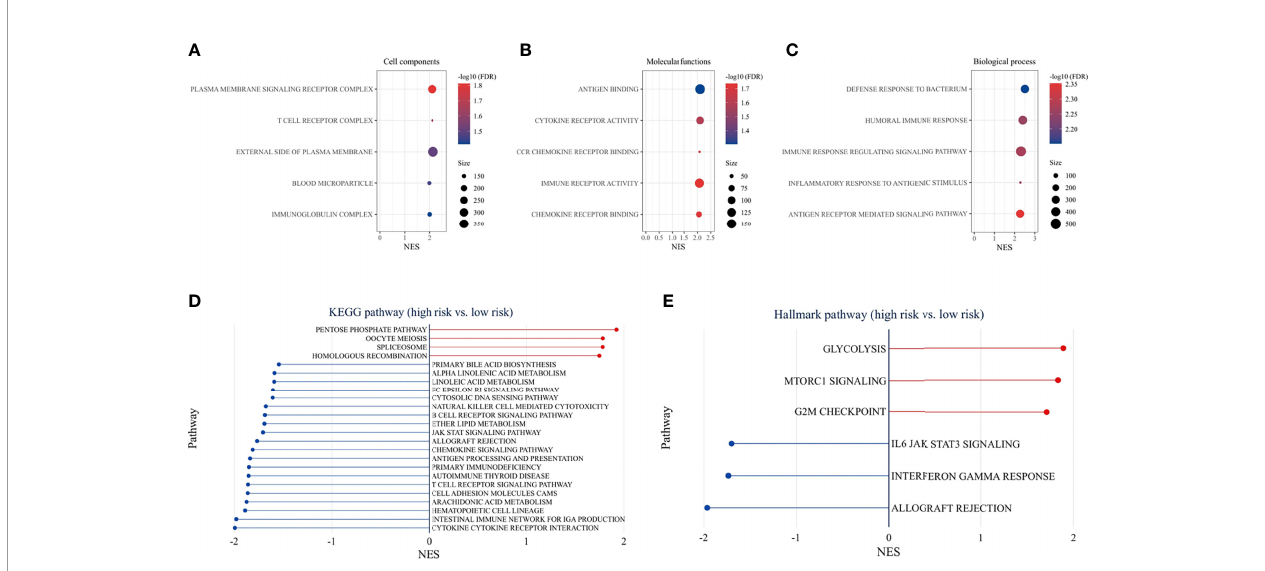
FIGURE 9 | Functional enrichment analysis. GO pathway enrichment analysis revealed top 5 GO terms in cellular components (A) , molecular functions (B) , and biological process (C) . KEGG pathway analysis (D) and hallmark pathway analysis (E) between the high-risk and low-risk groups ( p < 0.05 and FDR <25% were